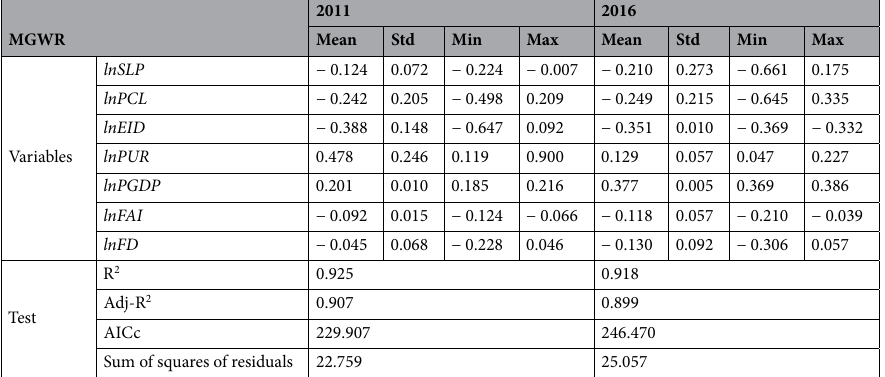
Table 5. The statistical description of the MGWR